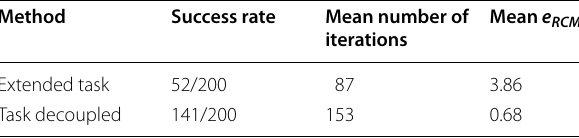
Table 1 Reach target with random initial joint values Method